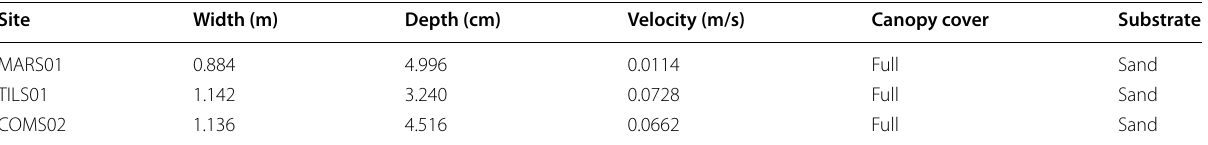
Table 1 Physical characteristics of stream reaches used for the temporal assessment of impacts of subsurface drainage on cellulose decomposition and benthic respiration in a forested network in Southern Ontario, Canada